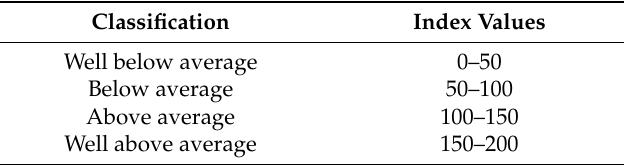
Table 3. Classification scheme for index values.